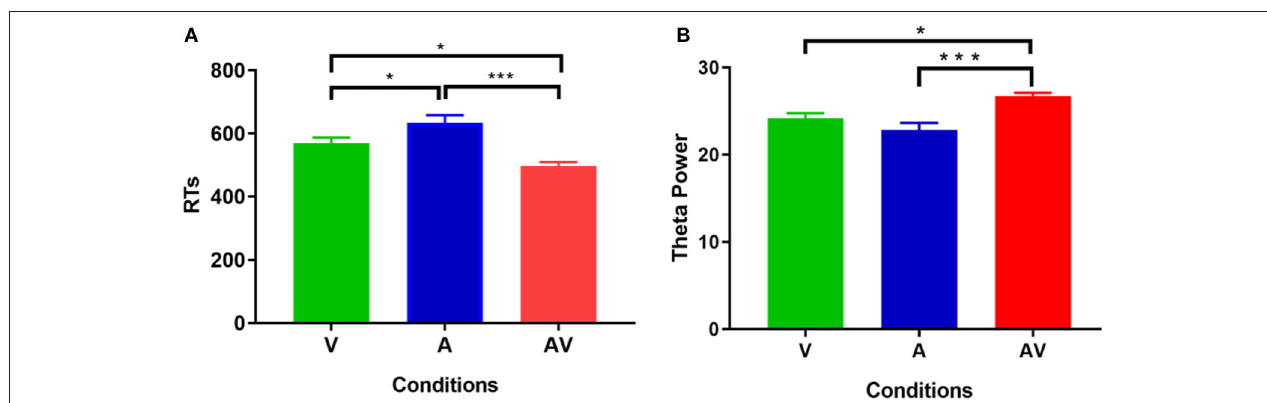
FIGURE 2 | Statistical results of behavioral data. (A) Comparisons of RT for memory retrieval among the three conditions (V, A, and AV). (B) Comparisons of power spectral density in theta frequency among the three conditions (V, A, and AV) during the encoding phase of working memory processing (0–600ms). The error bar presents the standard error of the mean. * p < 0.05; *** p < 0.001.